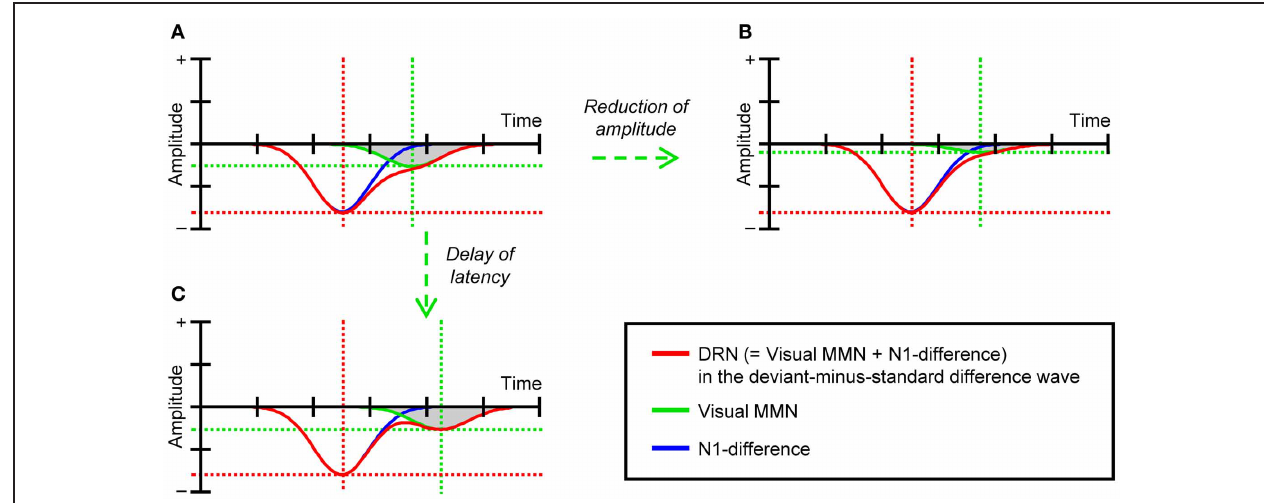
FIGURE 1 | (A) A schematic illustration of DRN, visual MMN, and N1-difference. (B) The modeled DRN as the sum of visual MMN with reduced amplitudes and N1-difference. (C) The modeled DRN as the sum of visual MMN with delayed latencies and N1-difference.